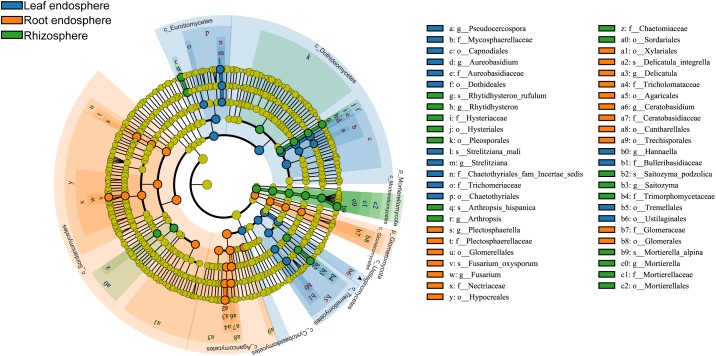
Cladograms of LEfSe showing fungal indicator taxa at each compartment. The filled circles from inside to outside indicate the taxonomic levels with phylum, class, order, family, genus, and species. Circles or nodes shown in color corresponding to different plant compartments represent a significant association.